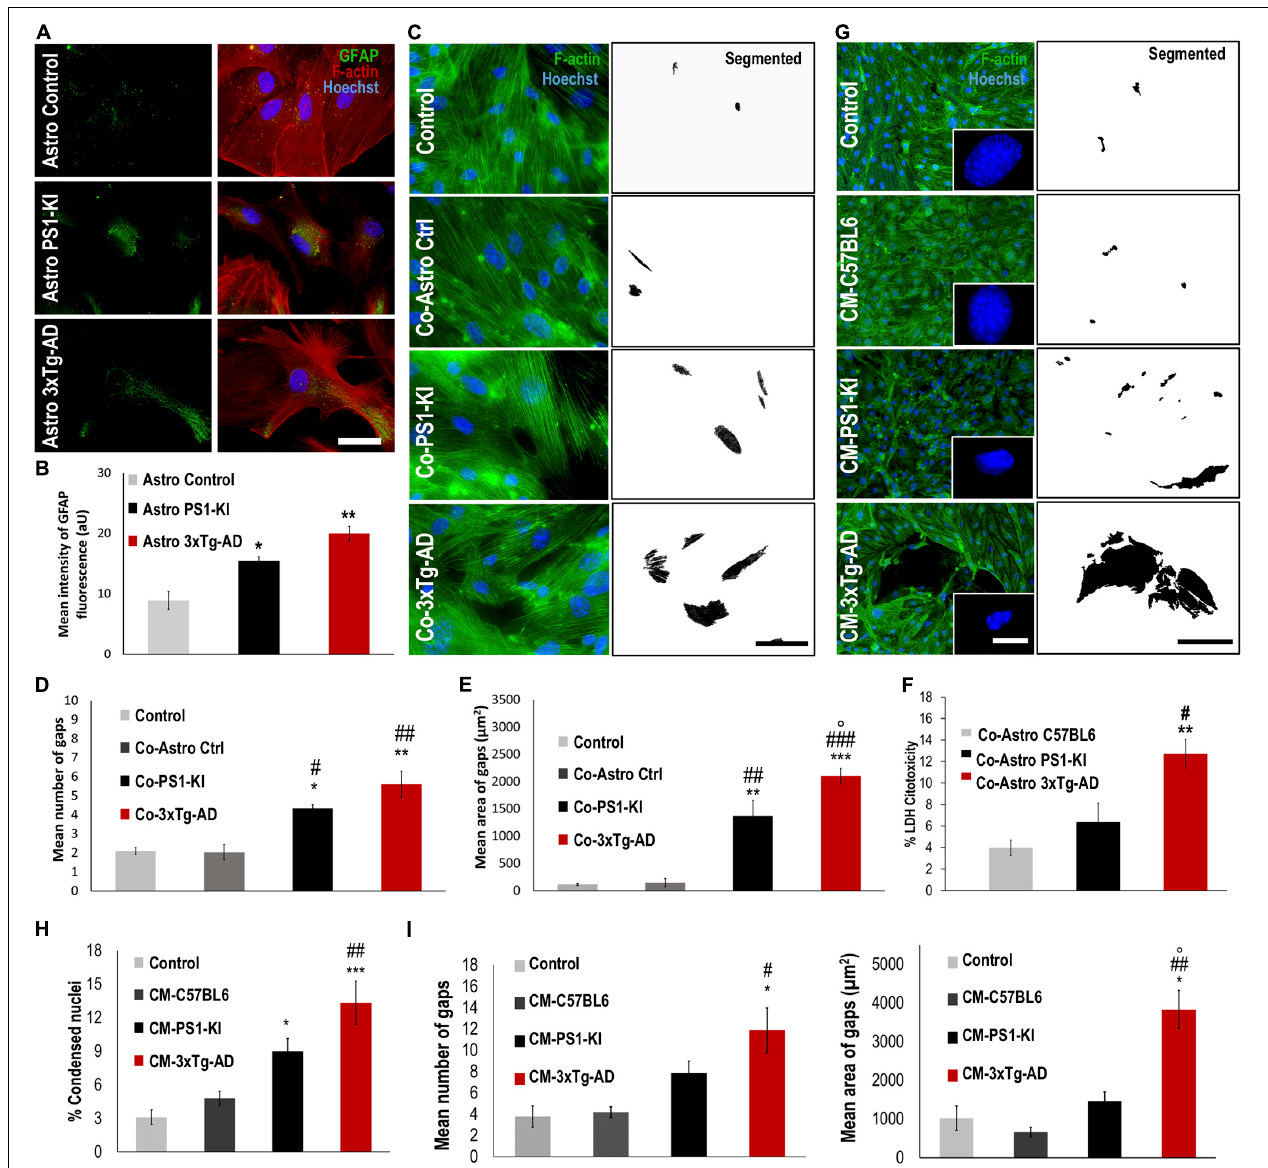
FIGURE 1 | CM from 3xtg-AD astrocytes induced endothelial alterations in the context of AD. (A) DIV 23-25 culture of control, PS1-KI and 3xTg-AD astrocytes. Reactivity of 3xTg-AD astrocytes. Hoechst staining of the nuclei is blue. Anti-GFAP-Alexa 488 staining of GFAP is green. Phalloidin-Alexa 594 staining of F-actin is red Calibration bar: 50 µ m. (B) GFAP fluorescence intensity quantification of 3xTg-AD astrocytes. Significant increase in GFAP intensity in treated 3xTg-AD astrocytes compared to that in the control samples. n = 3. Comparison with *, Control astrocytes Glu-; #, Control Coculture Glu-. P-value significance: **0.01; *0.05. (C) Endothelial cells cocultured with astrocytes from neonate 3xTg-AD. Hoechst staining of the nuclei is blue. Phalloidin-Alexa 594 staining of F-actin is green. Threshold details of cell-cell spaces in coculture with PS1-KI and 3xTg-AD astrocytes. Scale bar: 50 µ m. (D) Coculture with 3xTgAD astrocytes induced significant changes in the number of endothelial cell gaps. Ten fields per treatment were analyzed for each n. (E) Coculture with 3xTgAD astrocytes induced an increase in the average total area of gaps in vitro . Ten fields per treatment were analyzed for each n. n = 3. Comparison with *Control; #Co-Astro ctrl; ◦ Co-Astro PS1-KI. P-value significance: *** and ### 0.001; ** and ## 0.01; *, # , and ◦ 0.05. (F) Coculture with 3xTg-AD astrocytes increased cytotoxicity in endothelial cells. n = 3. Comparison with *Co-Astro C57BL6; #Co-Astro PS1-KI. P-value significance: **0.01; # 0.05. (G) Endothelial cells treated with CM from astrocytes for 24 h. Hoechst staining of the nuclei is blue. Phalloidin-Alexa 488 staining of F-actin is green. Details of condensed nuclei magnified to 100%; scale bar 4 µ m. (H) Average percentage quantification of condensed nuclei. Comparison with *Control; #CM-C57BL6; ◦ CM-PS1-KI. P-value significance: ***0.001; ## 0.01; *0.05. (I) Treatment with CM from 3xTgAD astrocytes induced a significant increase in the number and area of gaps between endothelial cells cultured in vitro . Twenty-five fields per treatment were analyzed for each n . n from 4 to 8; comparison with *Control; #CM-C57BL6; ◦ CM-PS1-KI. P-value significance: ## 0.001; *, # , and ◦ 0.05.